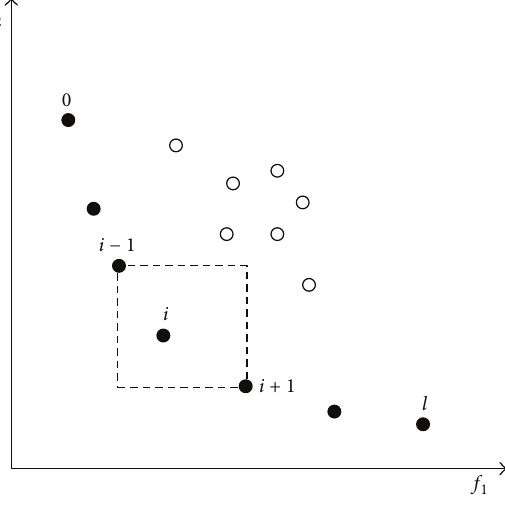
Figure 2: Chart of local crowding